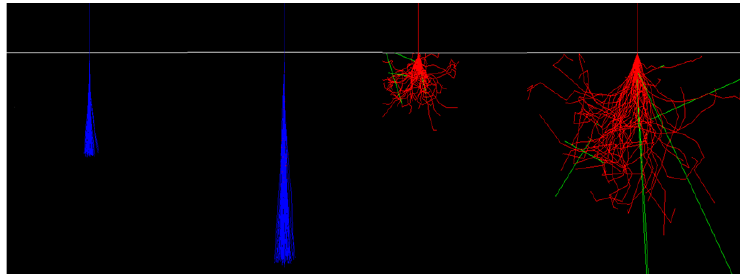
Figure 6. Scattering comparison between protons and electrons (Blue: protons; Red: electrons; Green: Protons path).